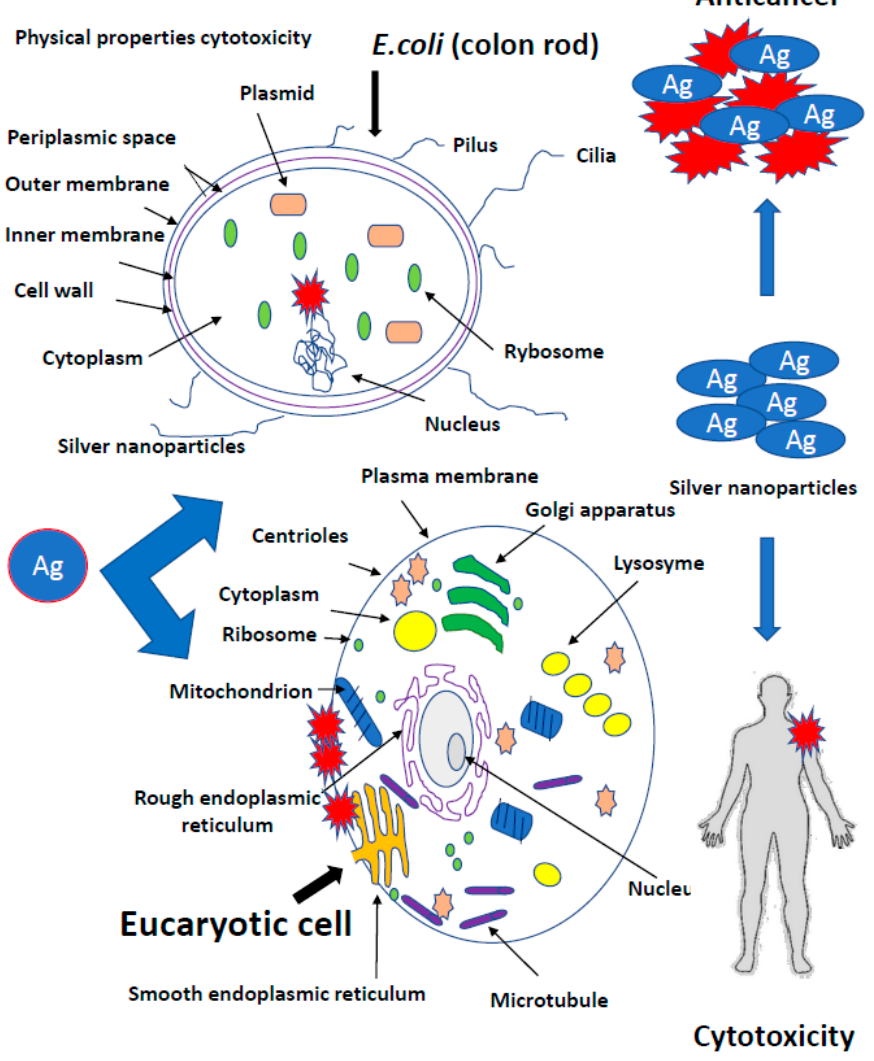
Figure 5. Toxicity of silver nanoparticles in different type of tissues. The role of toxicokinetic and toxicology of nanomaterials (especially in oral contact) and their effect on the environment.